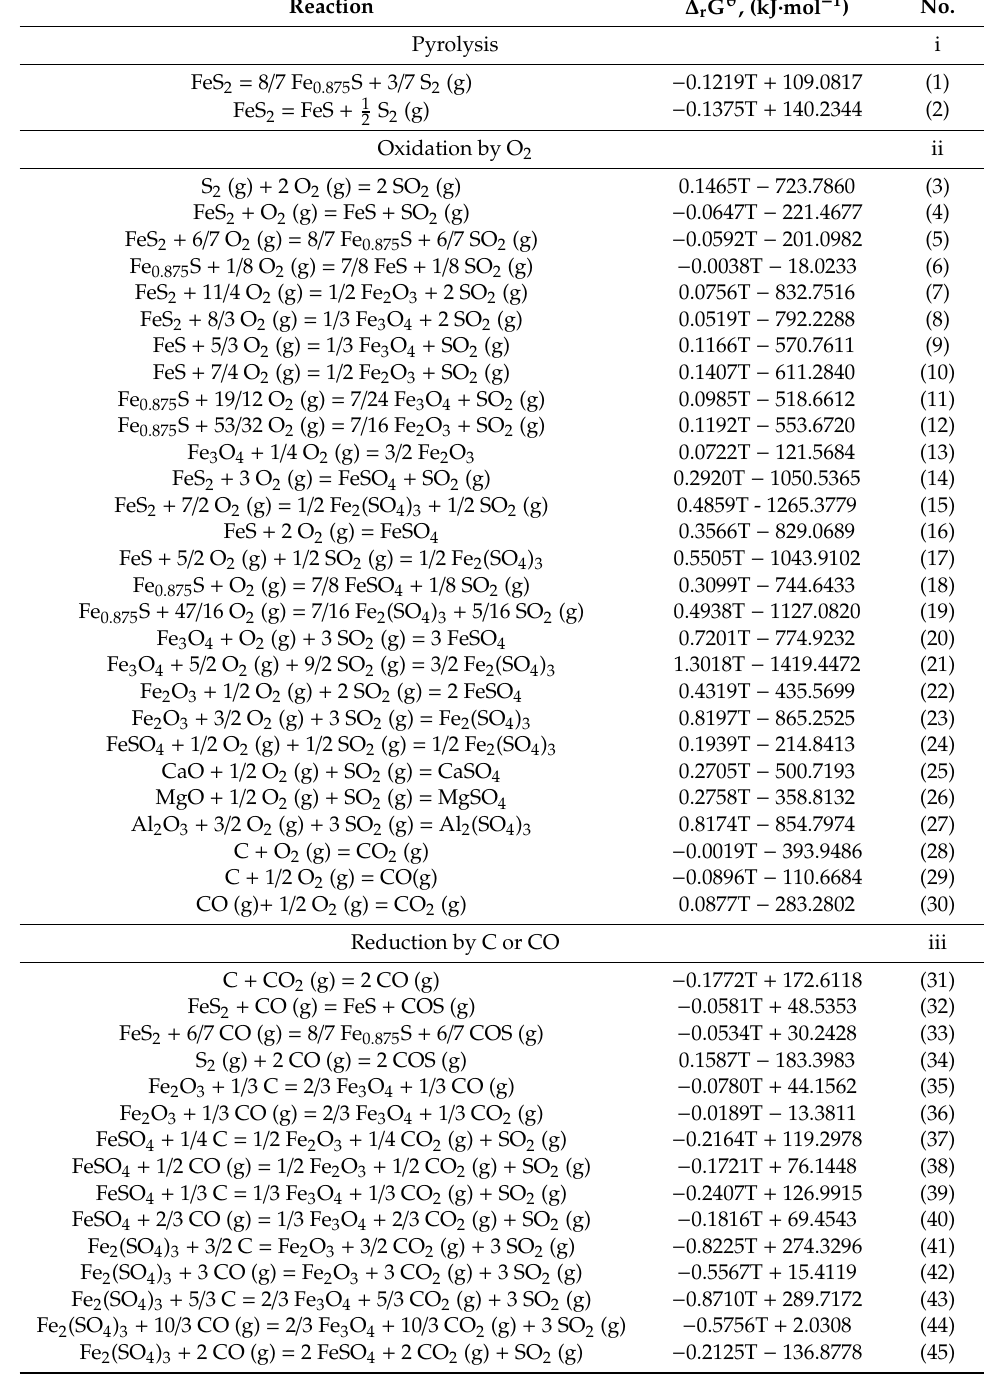
Table 1. Possible chemical reactions and corresponding ∆ r G θ at temperatures of 300–1200 K